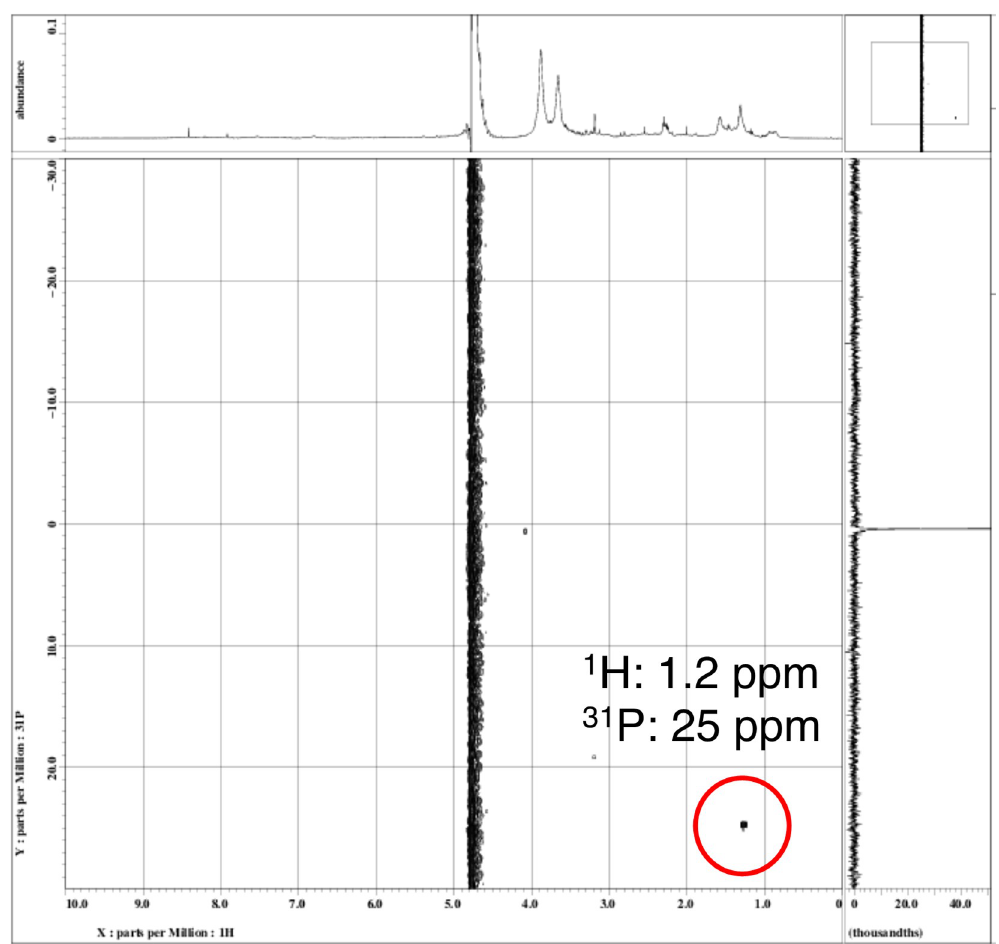
Figure 8. Two-dimensional ( 1 H- 31 P) NMR microscopy for suspended particles collected from the metalimnion showed the presence of phosphonate compounds (black spot inside the red circles) in the metalimnion of Lake Toya.